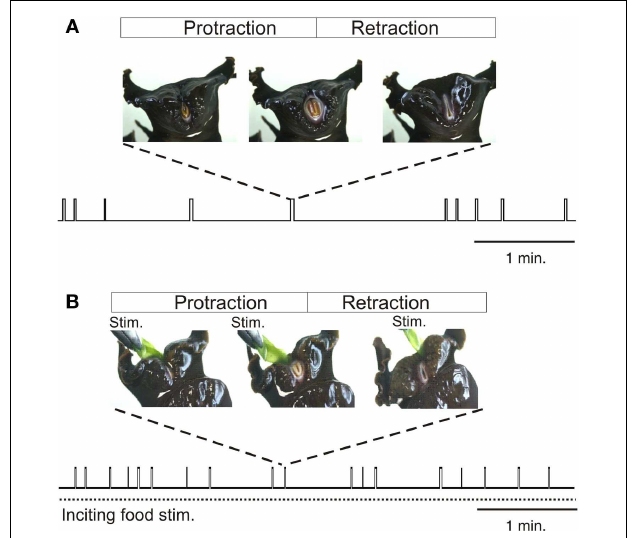
FIGURE 1 | Radula movements in freely behaving Aplysia . In the absence of food (A) or under continuous inciting stimulation with non-ingested food applied to the lips [Stim., (B) ], Aplysia spontaneously generates repeated cycles of protraction and retraction of its tongue-like radula (vertical bars).The distribution in time and the duration of radula movement cycles are highly variable and are not determined by any explicit sensory cue, although the mean frequency of cycle occurrences increases during inciting stimulation. Between successive radula cycles the animal engages in various other actions including lip movements, head-waving or locomotion which are all directed toward effective food seeking.